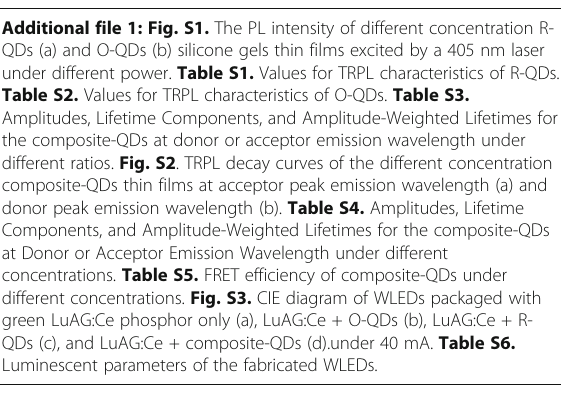
Abbreviations QDs: Quantum dots; WLEDs: White light-emitting diodes;